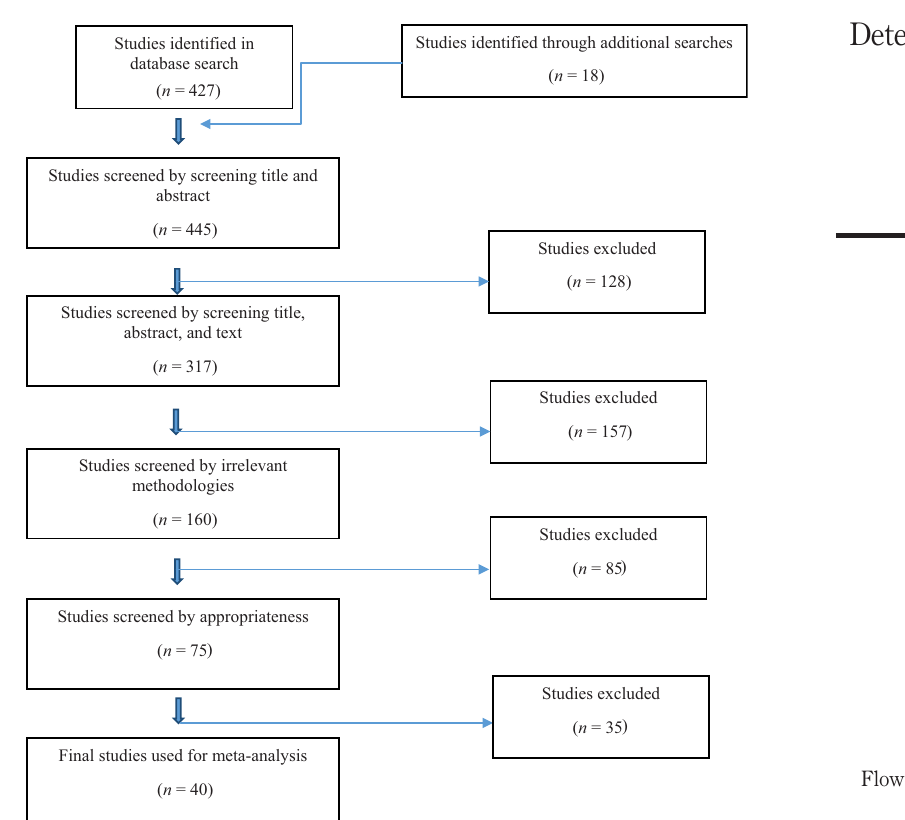
Figure 2. Flowchart for